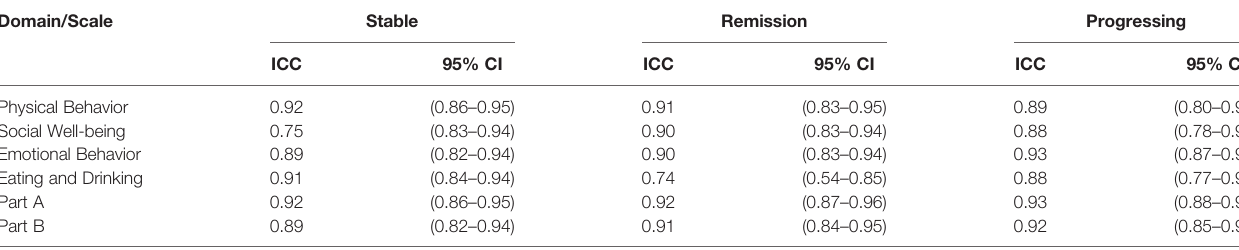
TABLE 4 | Intra-class correlation coef fi cients of HM-PRO for the three-states of disease. Domain/Scale Stable Remission